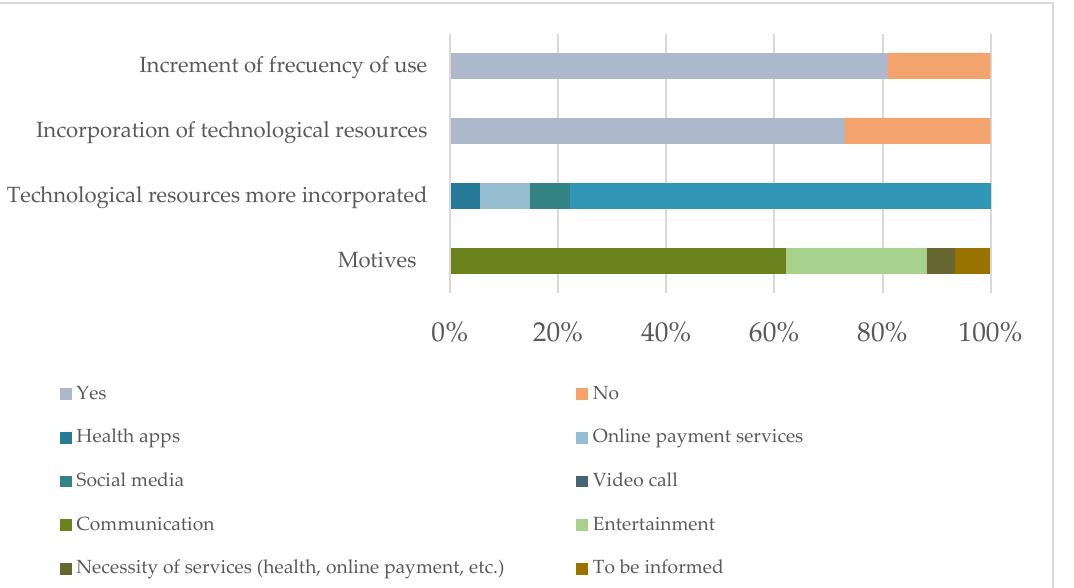
Figure 3. Main results of the digital profile of elderly as a result of COVID-19.